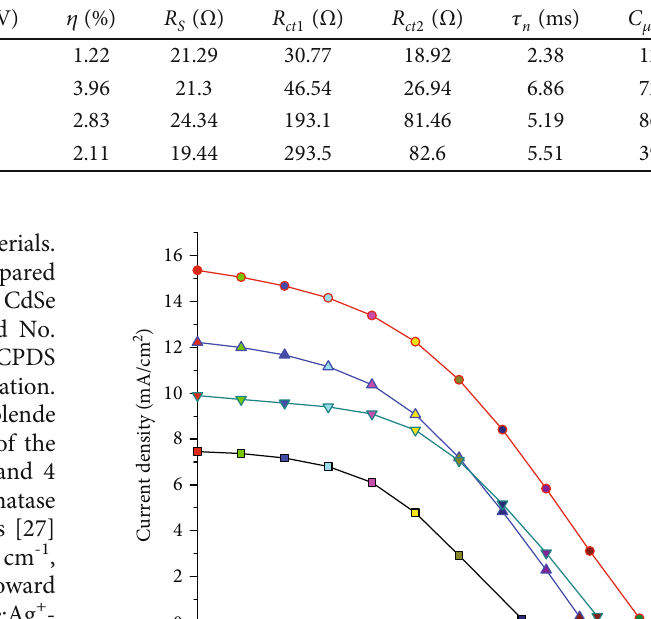
Table 2: The values of J-V curves and EIS with thickness from 1 layer to 4 layers.